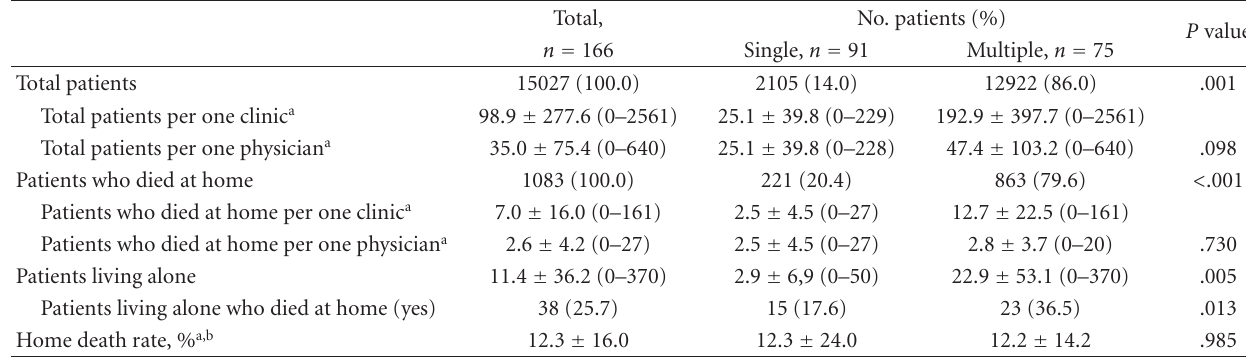
Table 2: The number of